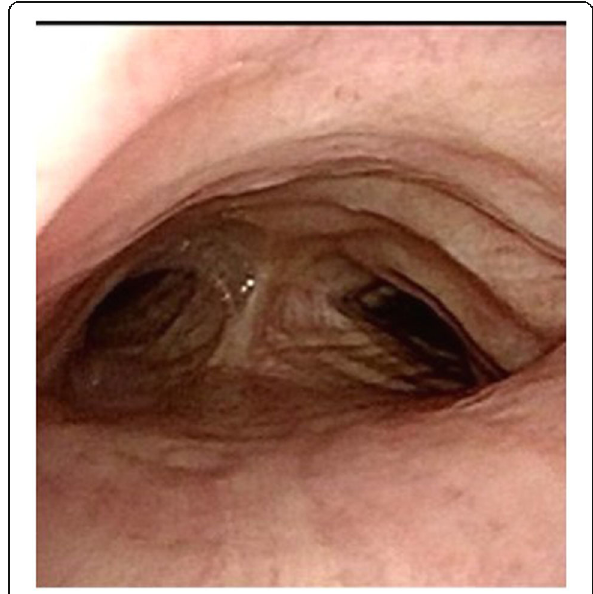
Fig. 3 Postoperative bronchoscopy. The area that had been constricted preoperatively remains constricted at 6 months postoperatively